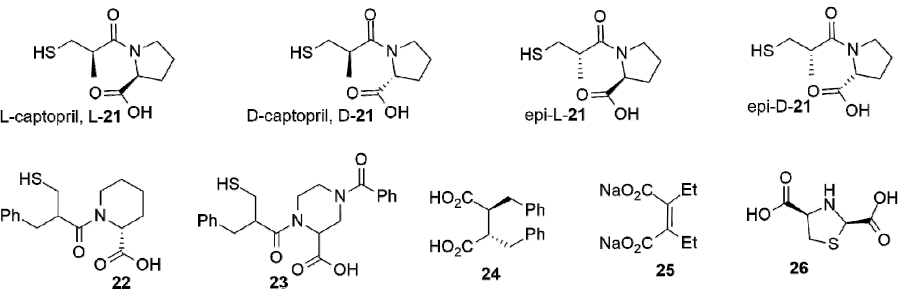
Figure 10. Intermediate and product mimic compounds studied as MBL inhibitors.